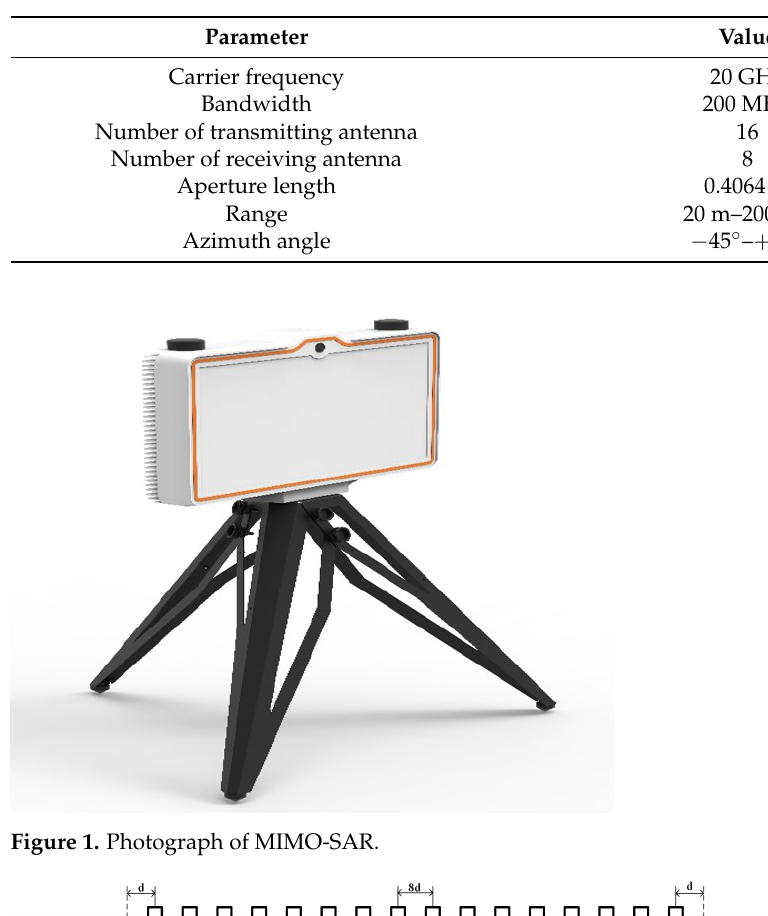
Table 1. Main parameters of MIMO-SAR system.